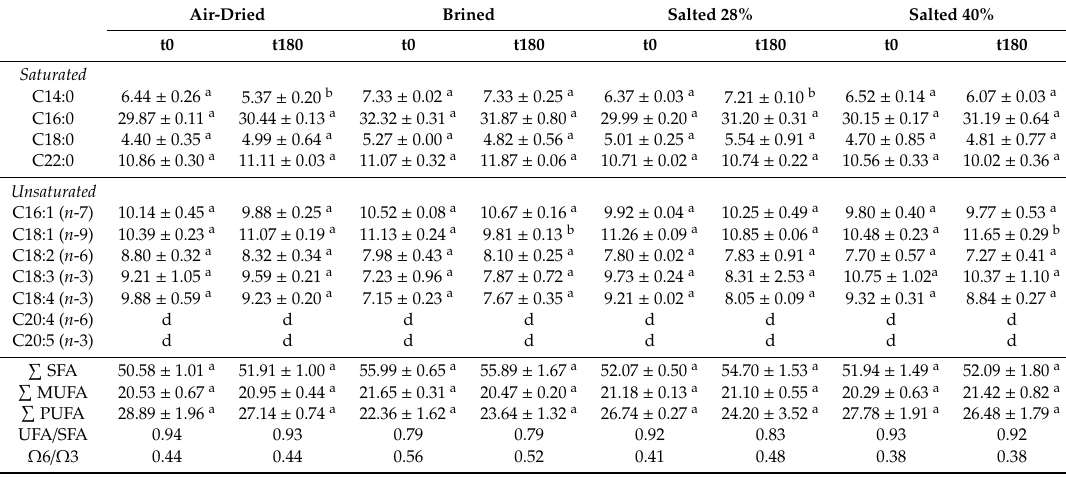
Table 3. Fatty acid composition (relative abundance (%) of total) of Ulva rigida submitted to di ff erent preservative processes (air-drying, brining, salting at 28% and 40%) just after the application of treatment (t0) and after six months of storage (t180). Air-Dried Brined Salted 28% Salted